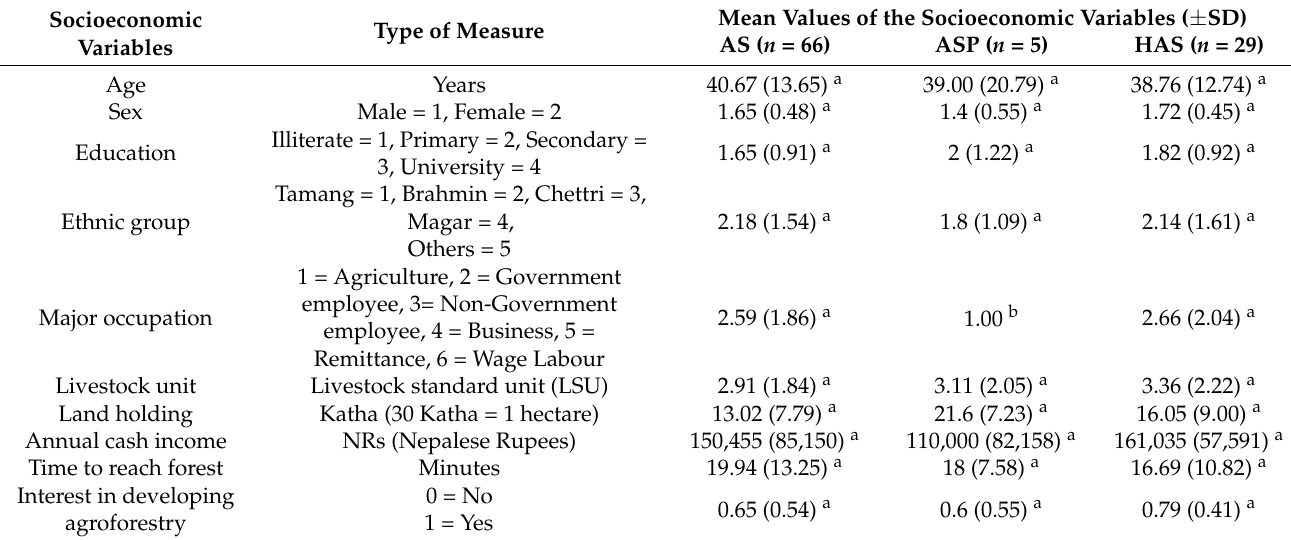
Table 2. Characteristics of the respondents in the study